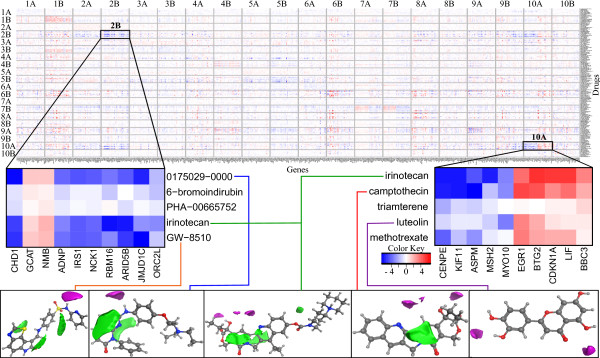
Finding interesting components. Heatmap across the 10 highest scoring significant CCA components: X-axis lists the top 30 significant genes in each subcomponent, while y-axis represents the top 20 scoring compounds in each. Two unique components 2B and 10A are zoomed in to show the detailed expression pattern along with 3D VolSurf descriptors (green areas are the lipophilic fields and the purple water fields). Only a subset (5 compounds and 10 genes) is shown in the zoomed version due to space constraints.